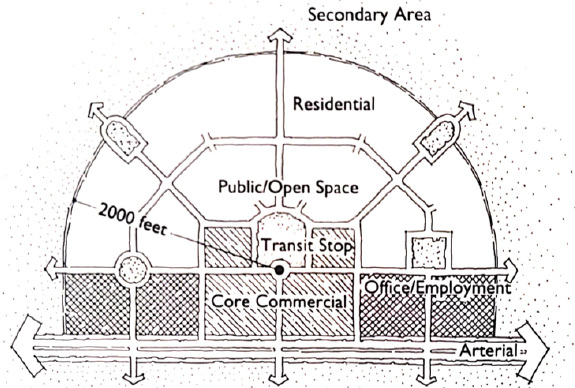
Figure 1. The concept map of TOD (Peter Calthorpe, 1993).